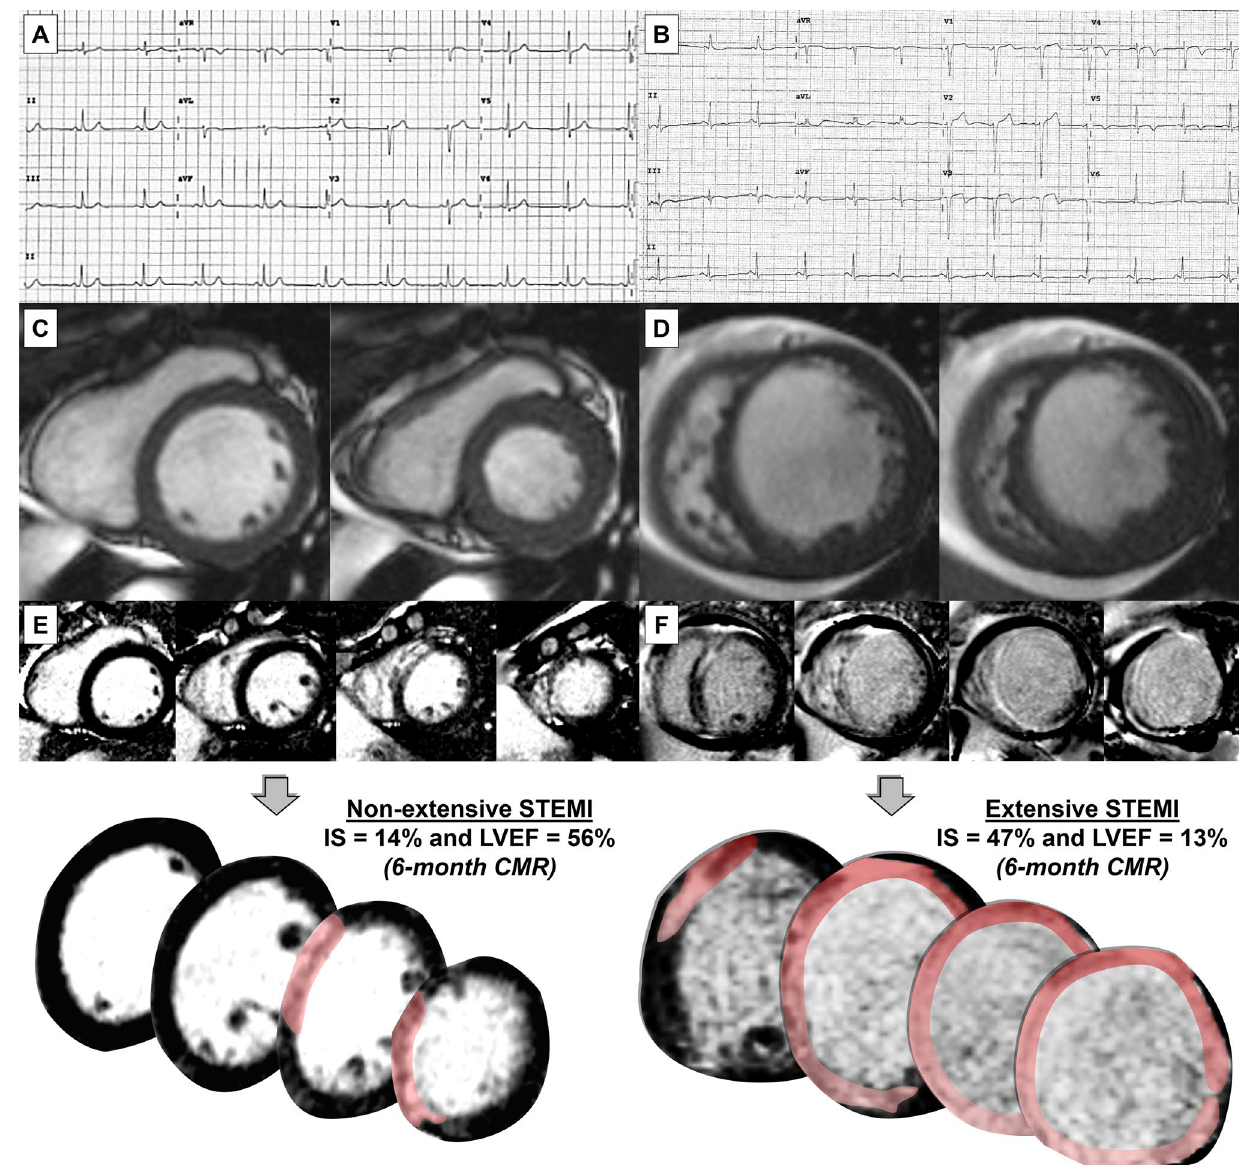
Figure 3. Examples of Q-STE and structural changes at 6-month CMR. Pre-discharge ECG showing no Q-STE ( A ) and Q-STE in ≥ 2 leads ( B ). Short axis CMR in diastole (left) and systole (right) indicating preserved ( C ) and reduced (< 40%, D) LVEF at 6 months. Late gadolinium enhancement imaging depicting non-extensive ( E ) and extensive (> 30% of LV mass, F ) IS. Abbreviations: CMR = cardiac magnetic resonance. IS = infarct size. LV = left ventricular. LVEF = left ventricular ejection fraction. Q-STE = Q wave and residual STE > 1